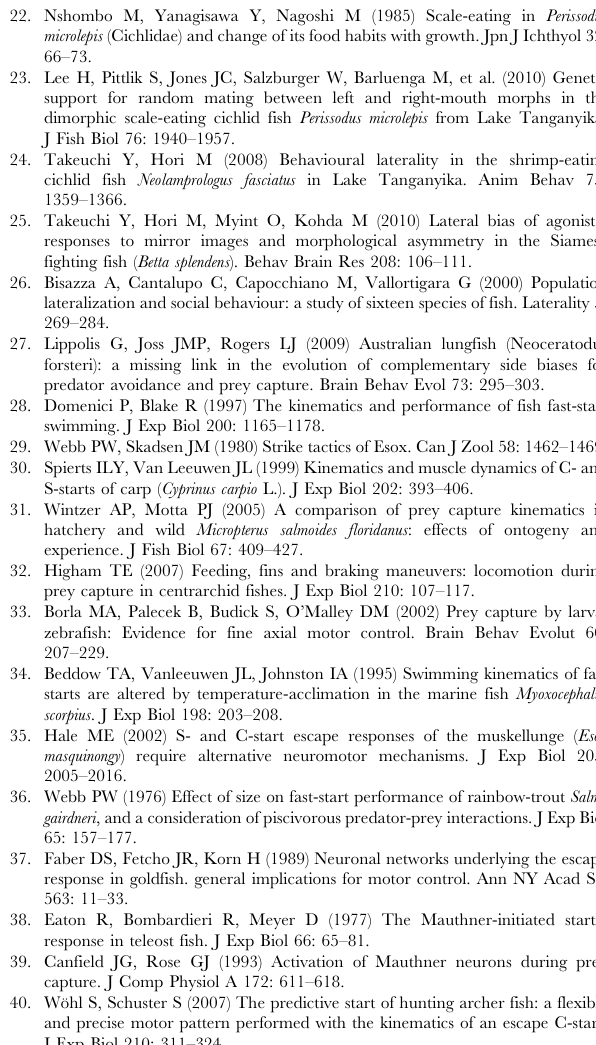
was larger than the right-side jaw. Scale bar = 5 mm.